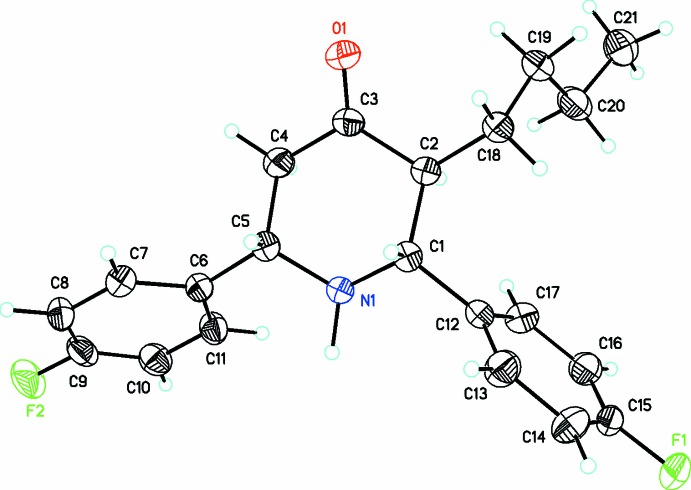
A view of the mol­ecular structure of C21H23F2NO, showing displacement ellipsoids drawn at the 30% probability level.